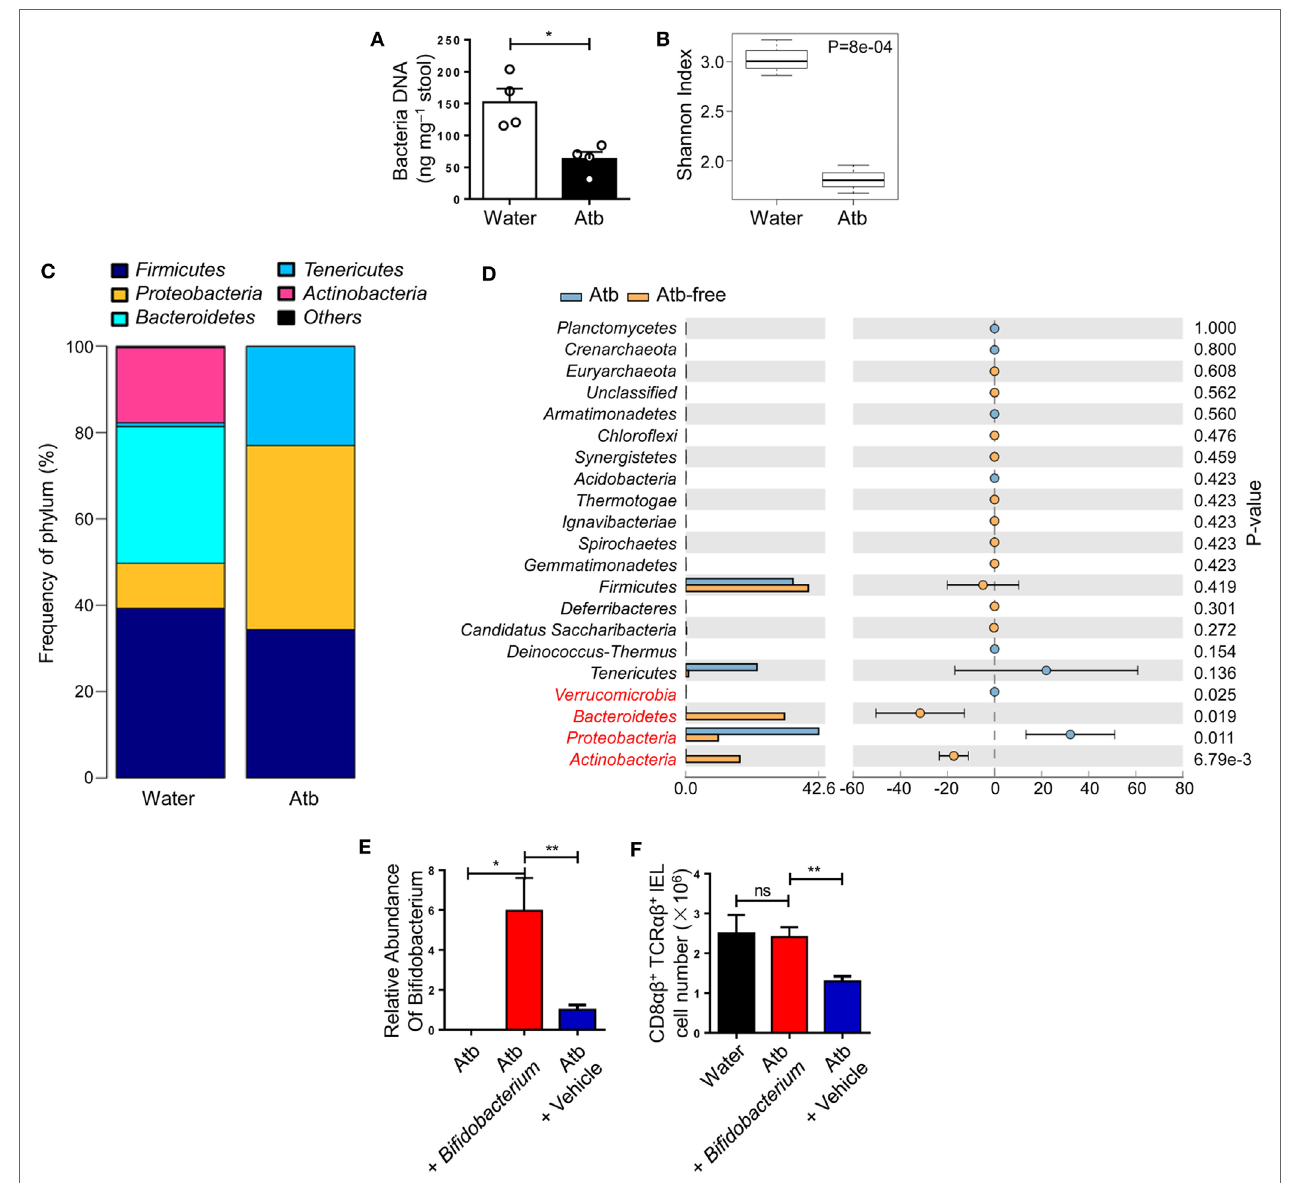
FigUre 2 | Global diversity of commensal bacteria affects the quantity of CD8 αβ + IELs. (a–D) Three-week-old mice were treated with normal water or water containing a combination of antibiotics (metronidazole, neomycin, ampicillin, and vancomycin) for 5 weeks. Analyses of 16S rDNA were done on bacterial DNA in the contents of the distal small intestine. (a) DNA load of bacteria in feces were detected (2 weeks post-treatment). (B) Plot of diversity using the Shannon Index. The Shannon Index of the two groups is shown to indicate the diversity of species. (c) Relative percentages of the dominant phylum in water-treated and Atb-treated mice were evaluated by the mean reads. (D) Distribution of intestinal bacterial groups in water-treated versus Atb-treated mice. The left portion indicates the proportion of the variety of bacteria phyla in water-treated and Atb-treated mice. The right portion indicates the difference in mean proportions between Atb-treated and water-treated groups, along with P -values and confidence intervals. (e) Quantitative PCR of bacterial DNA from fresh stool samples of mice pretreated with antibiotics for 2 weeks (left column); Atb-pretreated mice administered (i.g.) with Bifidobacterium (middle column) or vehicle (right column) (9 days post-transfer). Data show the relative abundance of Bifidobacterium in each group. (F) The absolute number of CD8 αβ + TCR αβ + IELs was detected (15 days post-transfer). Data from mice treated with normal water from birth (left column), Atb-pretreated mice administered (i.g.) with Bifidobacterium (middle column), or vehicle (right column) (15 days post-transfer) are shown. Data are representative of two independent experiments. Unpaired t -test. Error bars represent the mean ± SEM. * P < 0.05, ** P < 0.01. Abbreviations: ns, not significantly different; Atb, antibiotic; IEL, intraepithelial lymphocyte.